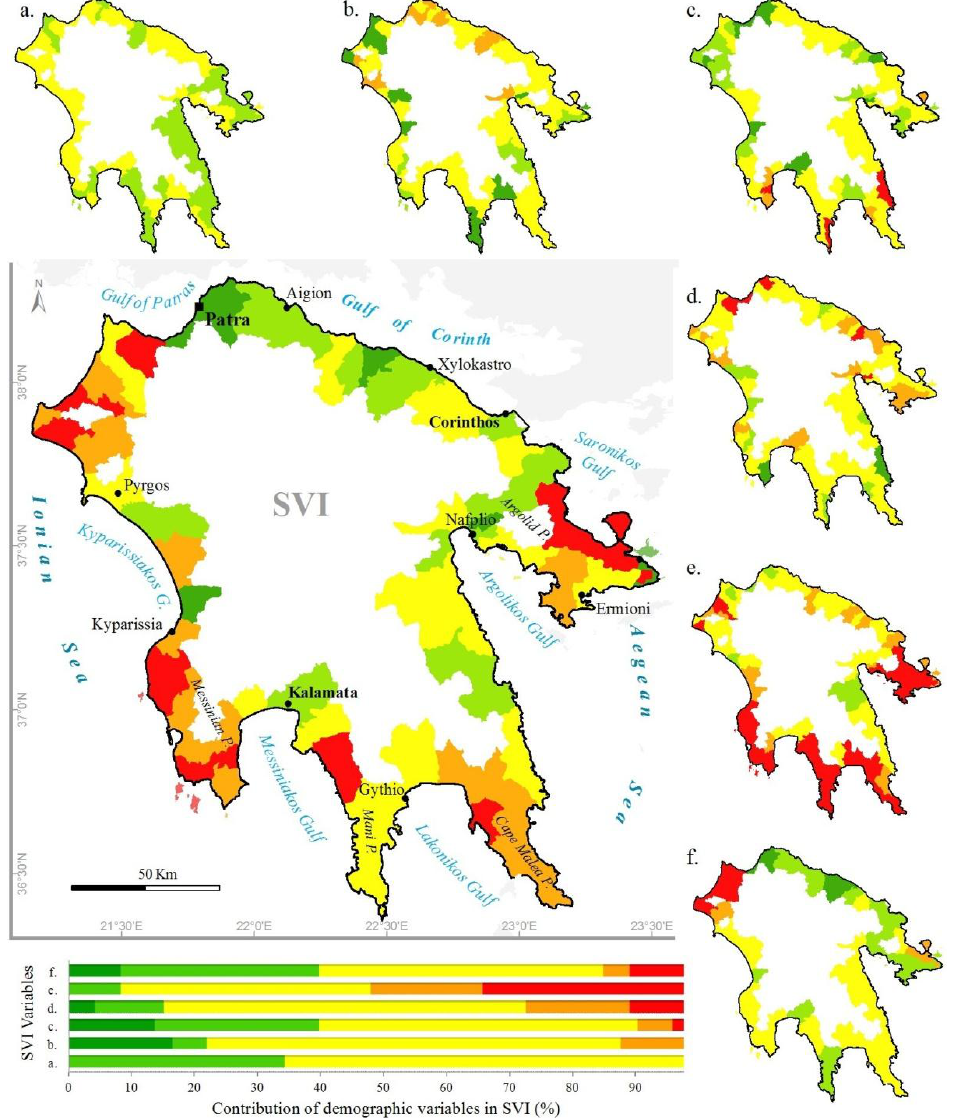
Figure 3. Maps of classification of the coastal municipal communities of the Peloponnese into five social vulnerability classes according to the variables of the Social Vulnerability Index (SVI) values. Inset maps ( a – f ) indicate the social vulnerability ranking of the communities based on the categorization of the SVI variables’ values (( a ) population density, ( b ) share of women in total population, ( c ) share of persons above 65 in total population, ( d ) share of children below 5 in total population, ( e ) share of foreign-born in total population and ( f ) share of low educated in total population). Inset bar diagram show the length (in percentage%) of shoreline in each vulnerability category for the SVI variables.